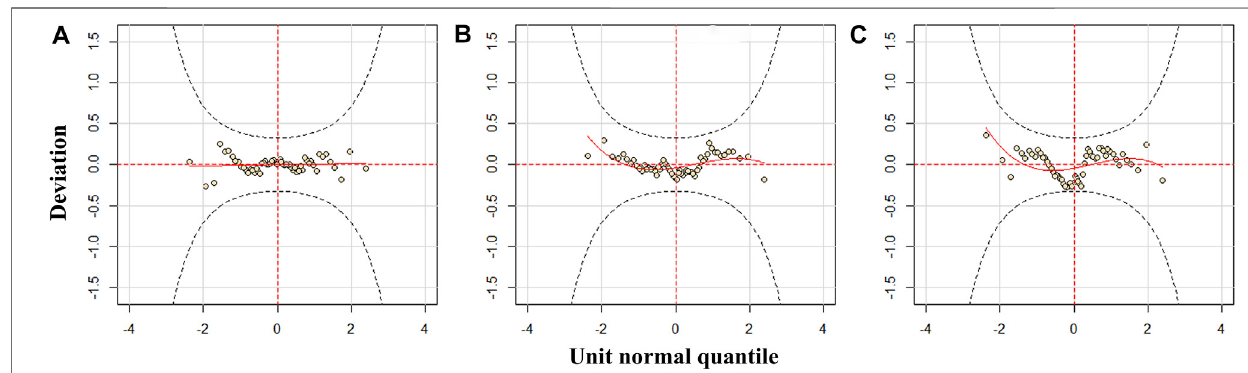
Frontiers in Environmental Science |